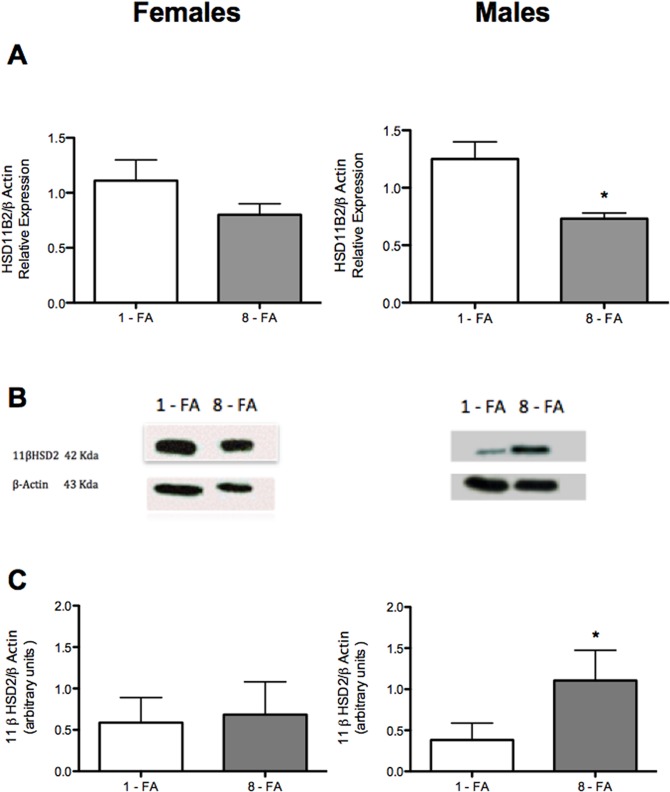
Expression of 11β-HSD2 in placentas attached to females and males.
HSD11B2 mRNA was determined by real time PCR as described in Materials and Methods. Results represent the HSD11B2/β actin ratio of duplicate experimental determination of 6 different biological samples of placentas attached to females and males from different litters (A). Western blot analysis for 11β-HSD2 protein expression in placentas attached to males and females (B). 11β-HSD2 western blot signals were determined by densitometry and expressed as arbitrary units related to β-actin (C). *p<0.05 compared to control; Mann-Whitney test.